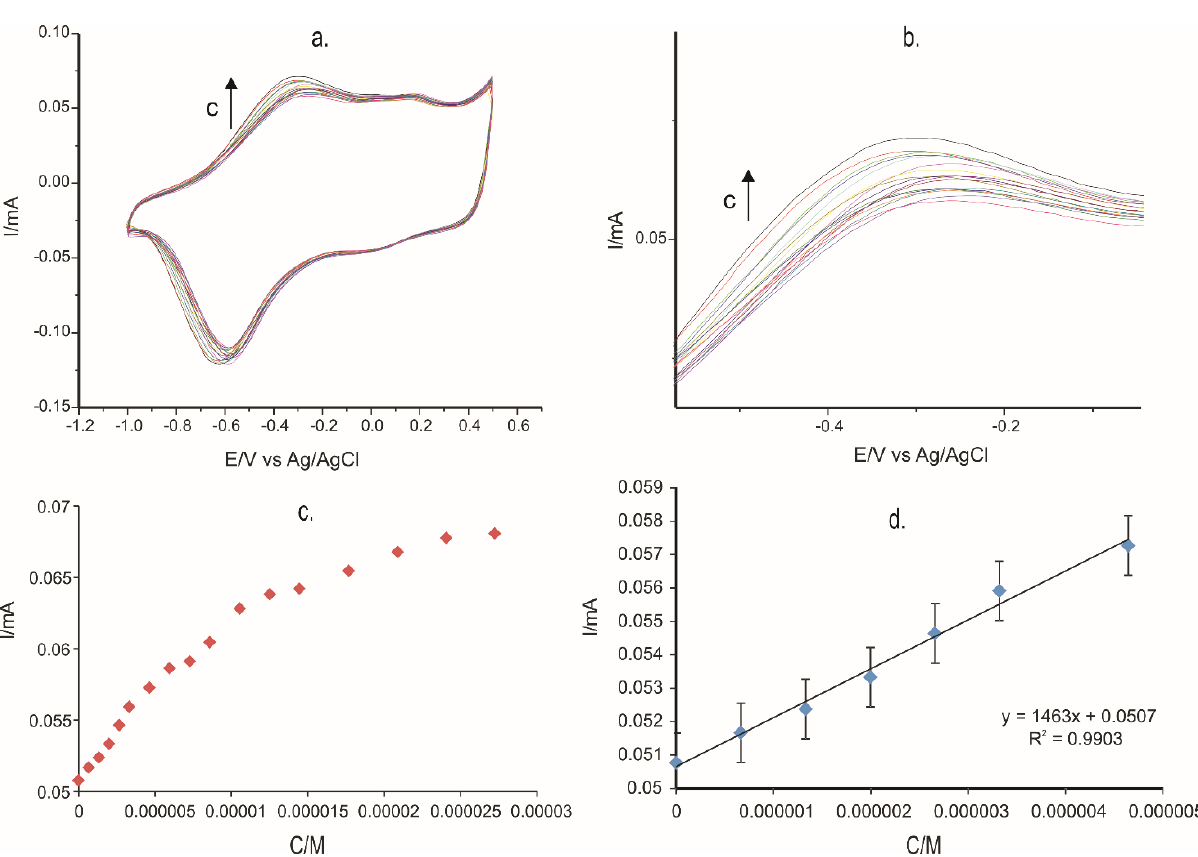
Figure 11. ( a ) Cyclic voltammograms obtained for different concentrations of L-Tyr in the range 0.5–27 × 10 − 6 M. ( b ) The zoom on the anodic peak for which the calibration curve was developed. ( c ) The anodic peak current I variation with Tyr concentration. ( d ) Calibration curve in the range 0.5–5 × 10 − 6 M.